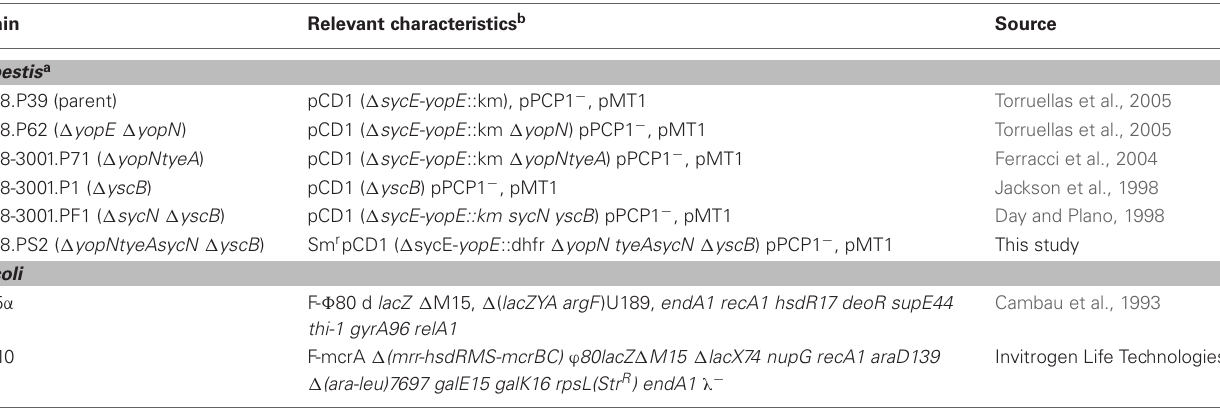
Table 1 | Bacterial strains used in this